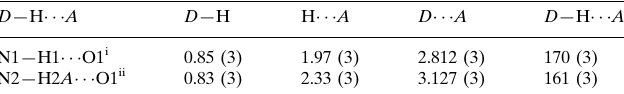
Hydrogen-bond geometry (A˚ , (cid:1)